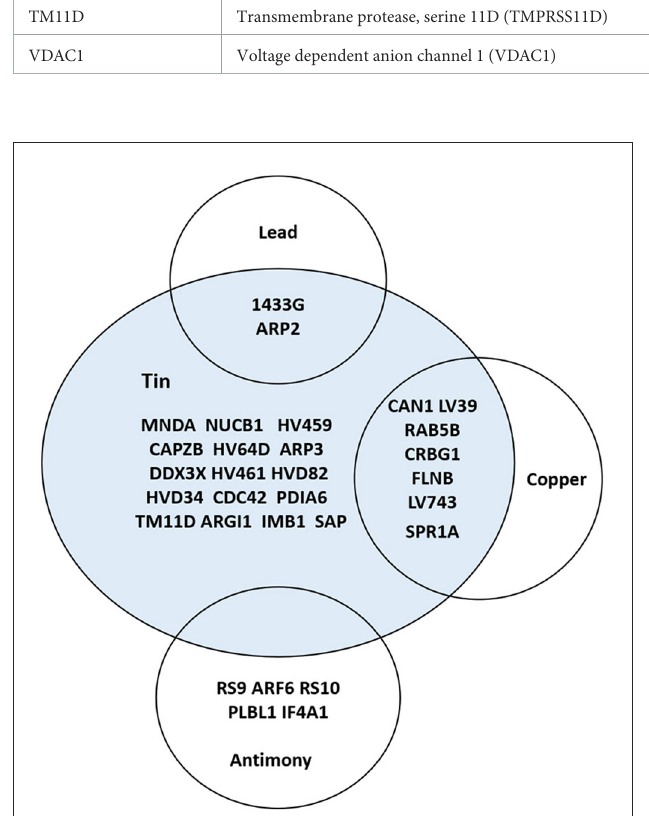
FIGURE2 VENN diagram depicting saliva proteins correlated with Ni, Cu, Zn, Sn, Sb, and Pb levels ( p <